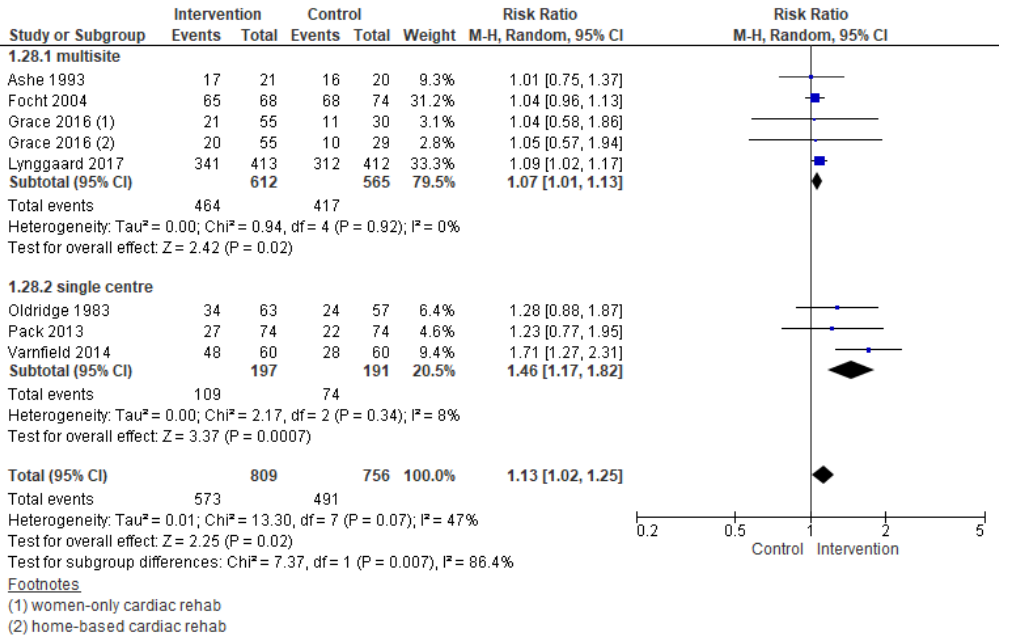
Figure 9. Forest plot for completion—number of sites. Note: Boxes represent the risk ratio (RR) for individual trials. The boxes are proportional to the weight of each study in the analysis and the lines represent their 95% confidence interval (CI). The diamond represents the pooled RR, and its width represents its 95% CI.